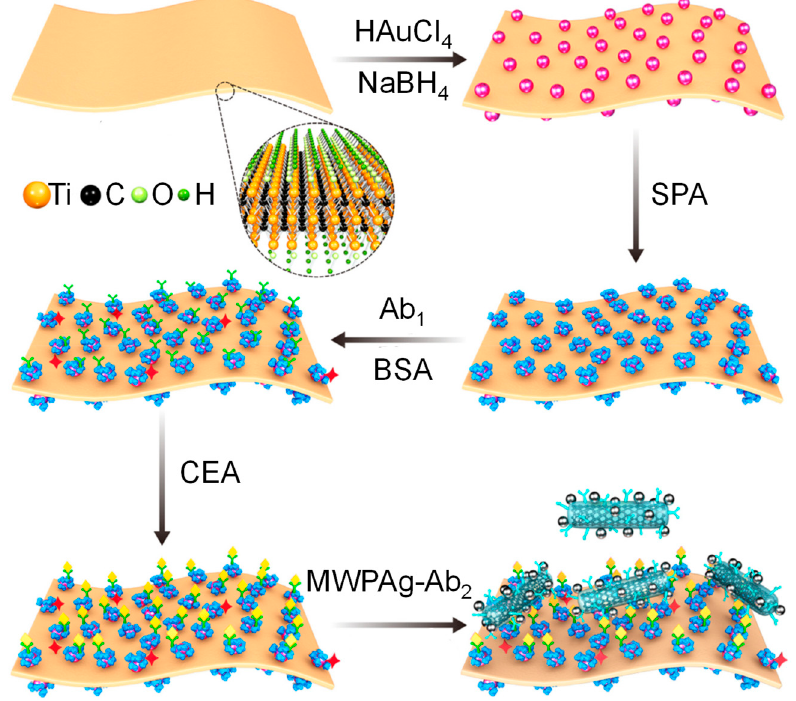
Figure 5. Construction of Ti 3 C 2 -MXene-based SPR sensor for CEA detection [71]. Reproduced with permission from [71].